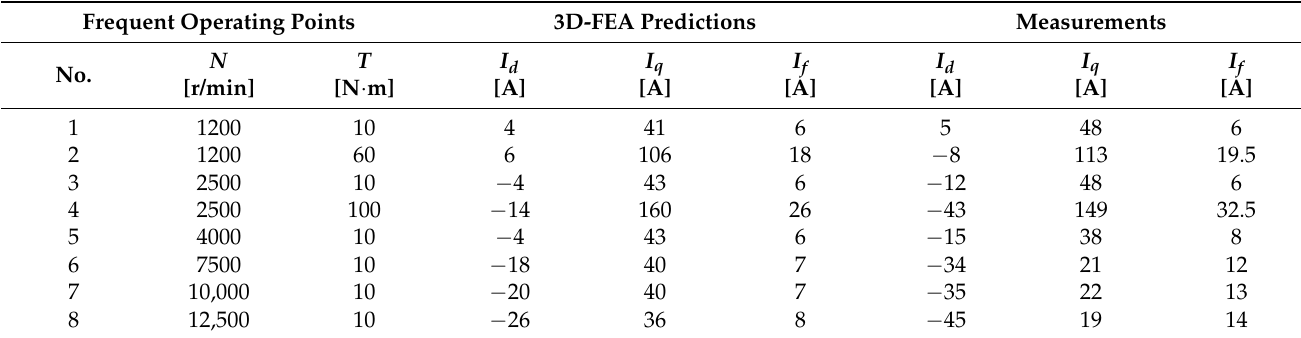
Table 3. Optimum current combinations I d - I q - I f for the given operating points under the 3D-FEA prediction and the